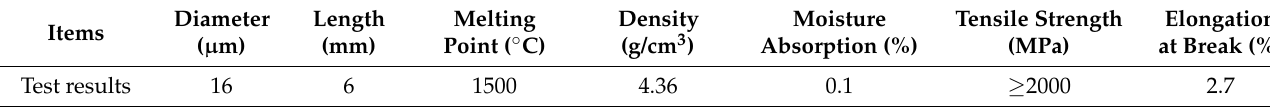
Table 1. The properties of basalt